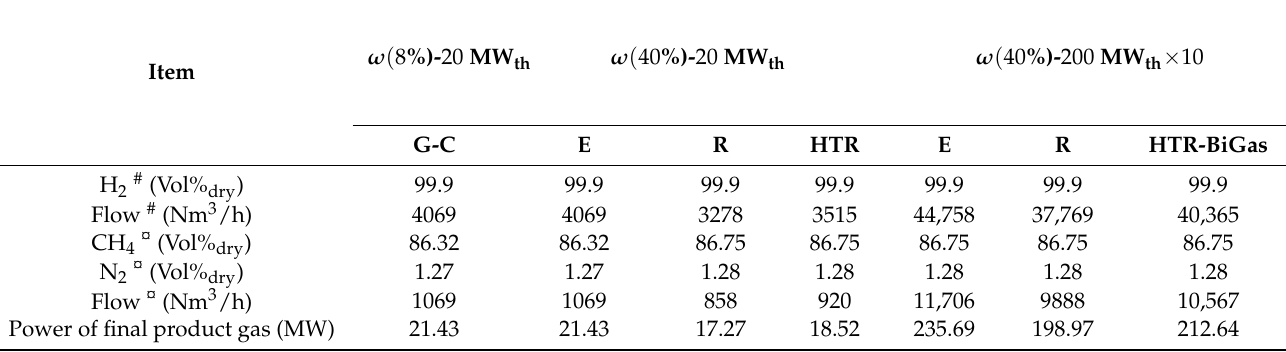
Table 5. Main contents of final product gas produced by a biomass gasification module of different designs.